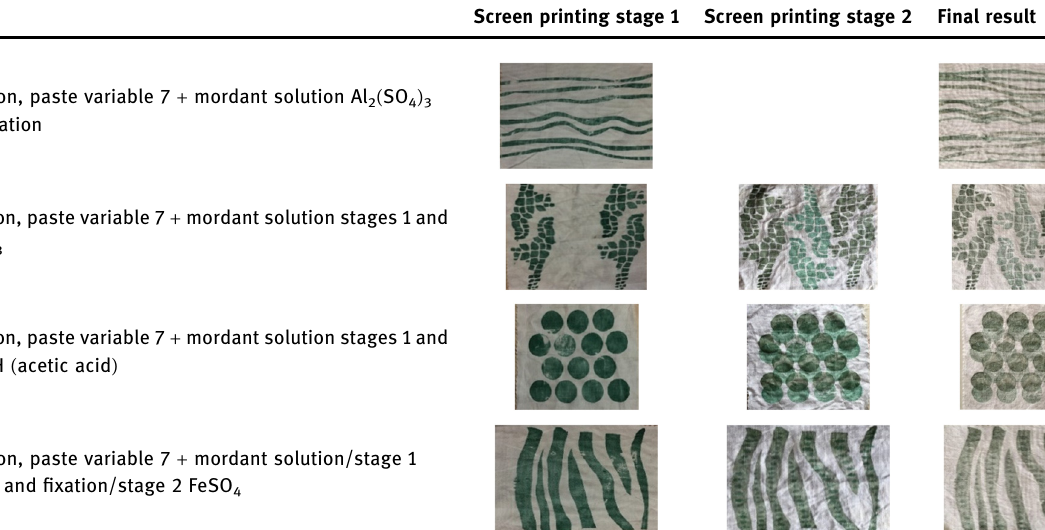
Table 7: Experiments on Spirulina platensis paste application on cotton with screen printing and fi xation Materials